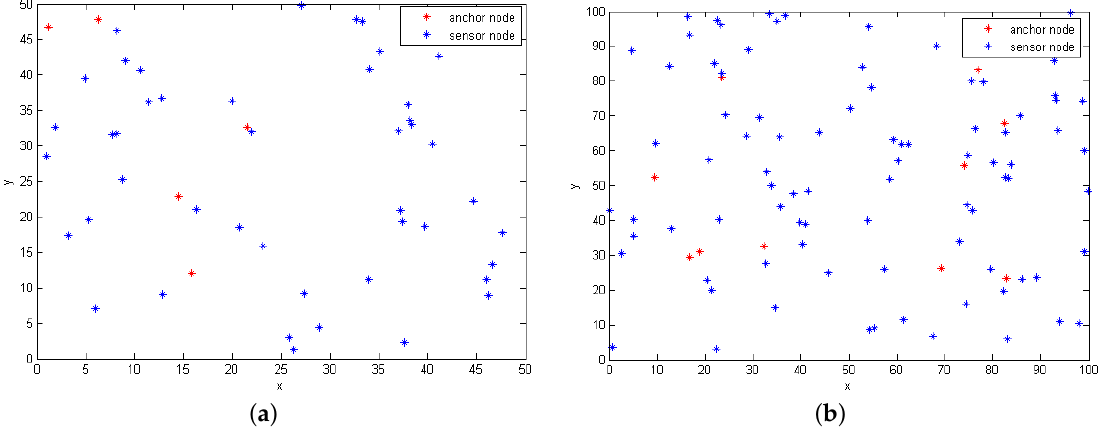
Figure 2. Different areas of node distribution. ( a ) There are 50 nodes in the area of 50 m × 50 m; ( b ) There are 100 nodes in the area of 100 m × 100 m.